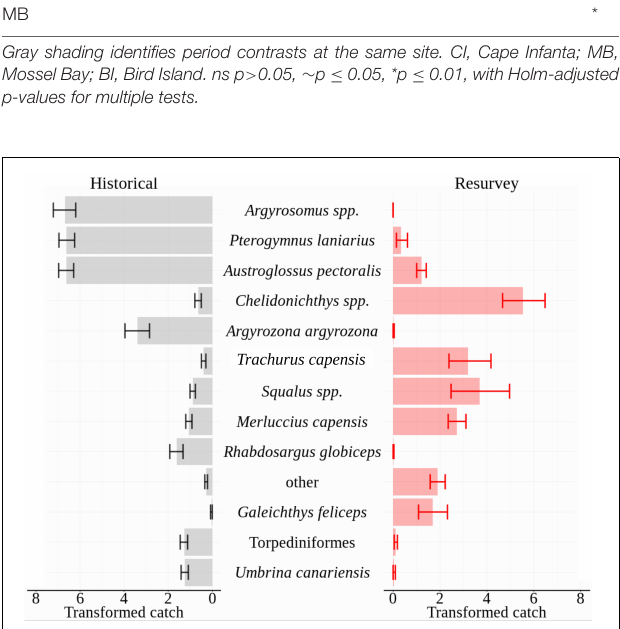
FIGURE 3 | Mean abundances of distinguishing taxa that cumulatively contributed 90% of dissimilarity between periods, as identified by SIMPER analysis. Taxa are plotted in order of contribution to dissimilarity. Standardized abundances (count · nautical mile − 1 ) were square-root transformed prior to analysis and plotting. SIMPER results for all taxa are tabled in the Supplementary Material . Error bars are non-parametric 95% confidence